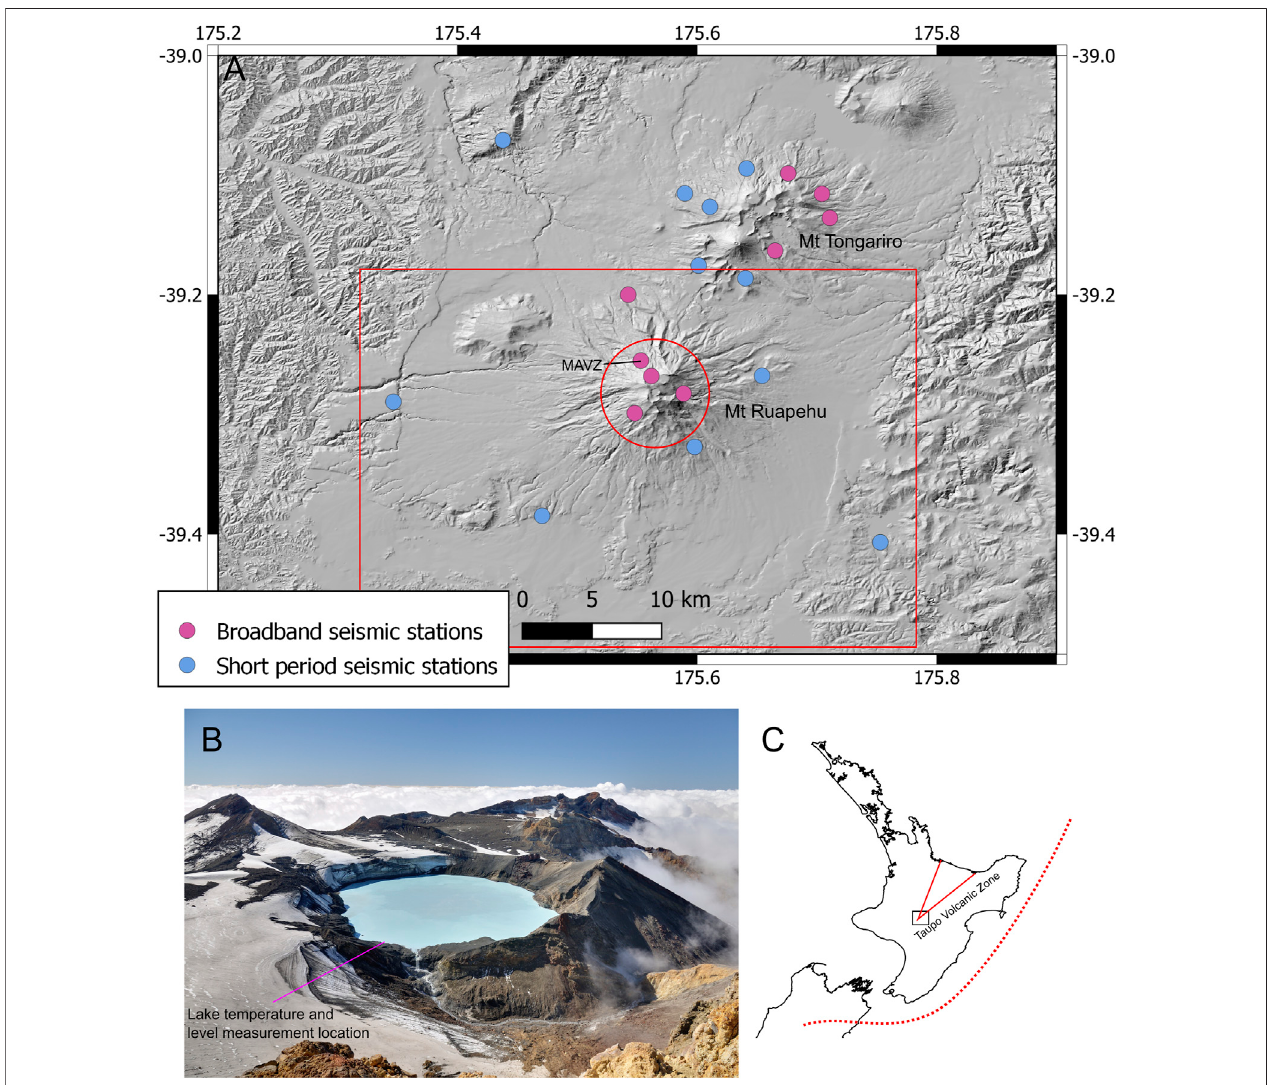
FIGURE3 |(A) Monitoring networkat MtRuapehu and Mt Tongariro, withinner region (red circle) and outer region (red square)for seismicity rate. (B) Crater Lake, Te Wai- ā -moe looking tothe north (c Visual Media Library,GNSScience, ID 113328, photographer Dougal Townsend).The outlet of thelake isvisiblein bottom edge of the lake in this photo and fl ows to the right (southeast). (C) TVZ outline (red line) and plate boundary (dashed line), rectangle box is location of map (A) .